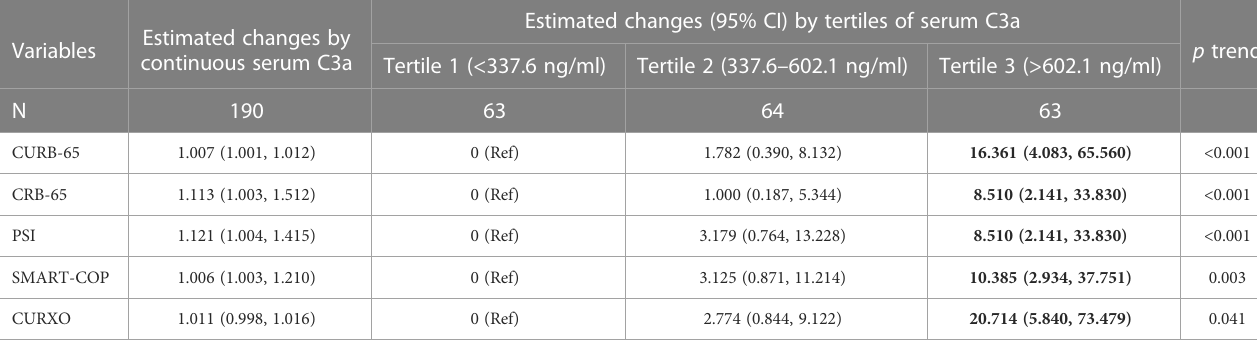
TABLE 4 Associations between serum C3a and CAP severity scores. Variables